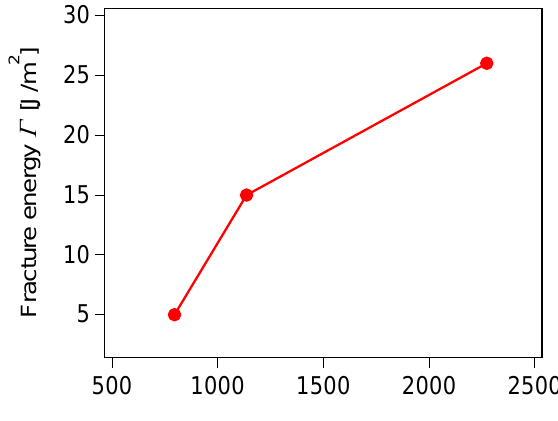
Figure 13. Fracture energy of SR gels with different molecular weights of PEG chains. Reprinted from [23] with permission from American Chemical Society.